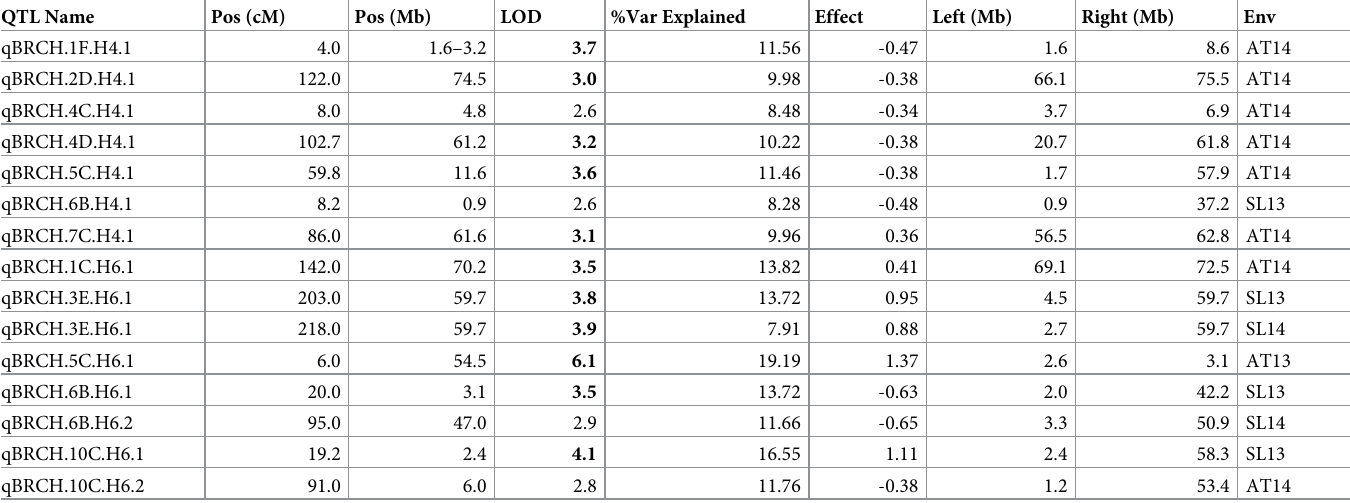
Table 2. Parameters of branching (BRCH) QTLs from interval mapping of the H4 and H6 SBSH-BC 1 F 2 populations.